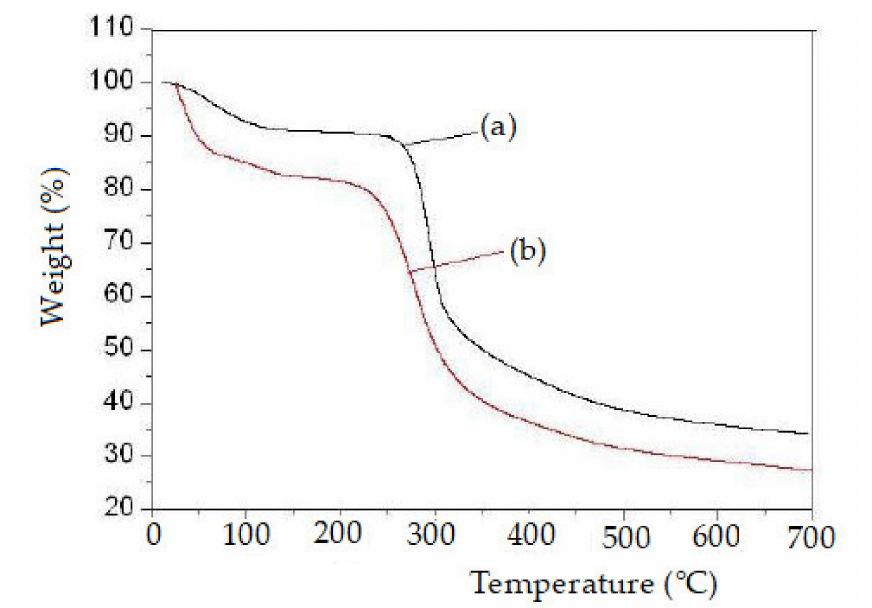
Figure 6. Thermogravimetric analysisof pure chitosan ( a ) and chitosan derivative ( b